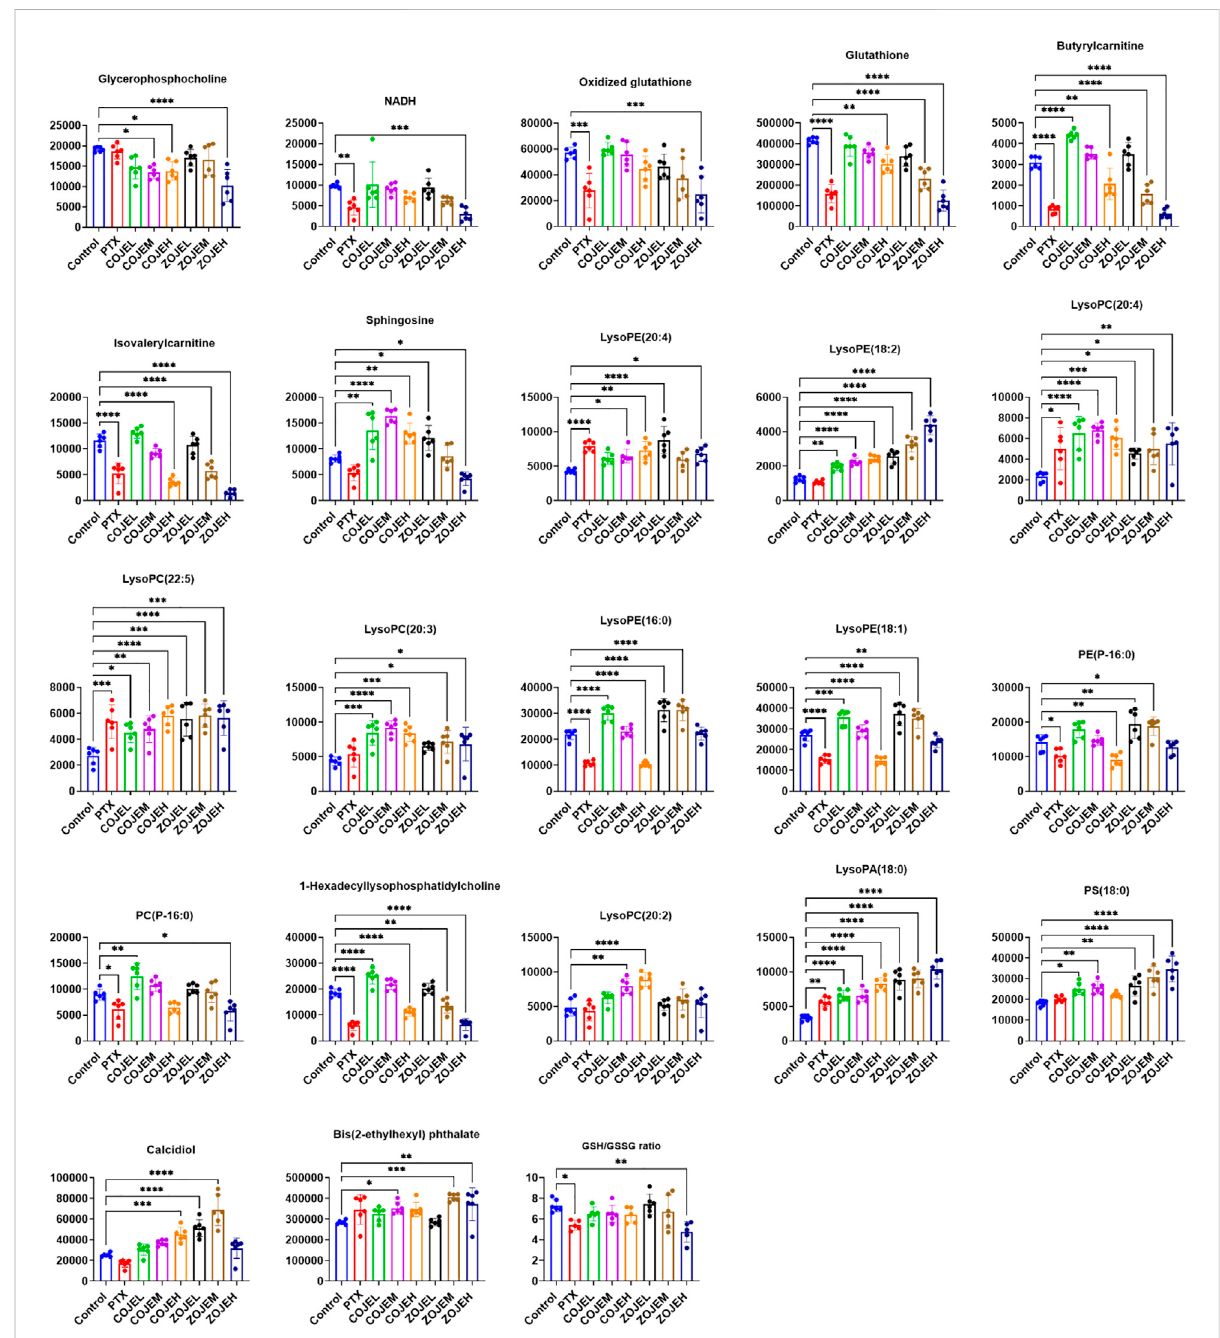
FIGURE 6 Changes in the relative peak intensities of 22 identi fi ed metabolites and the ratio of GSH/GSSG in different groups. (GSH, glutathione; GSSG, oxidized glutathione; * p < 0.05, ** p < 0.01, *** p < 0.001, **** p < 0.0001, compared with control